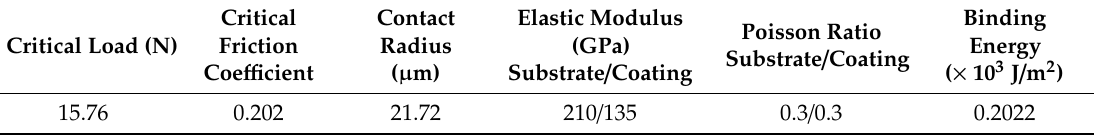
Table 3. Interface binding energy of the interface between zinc coating and substrate.